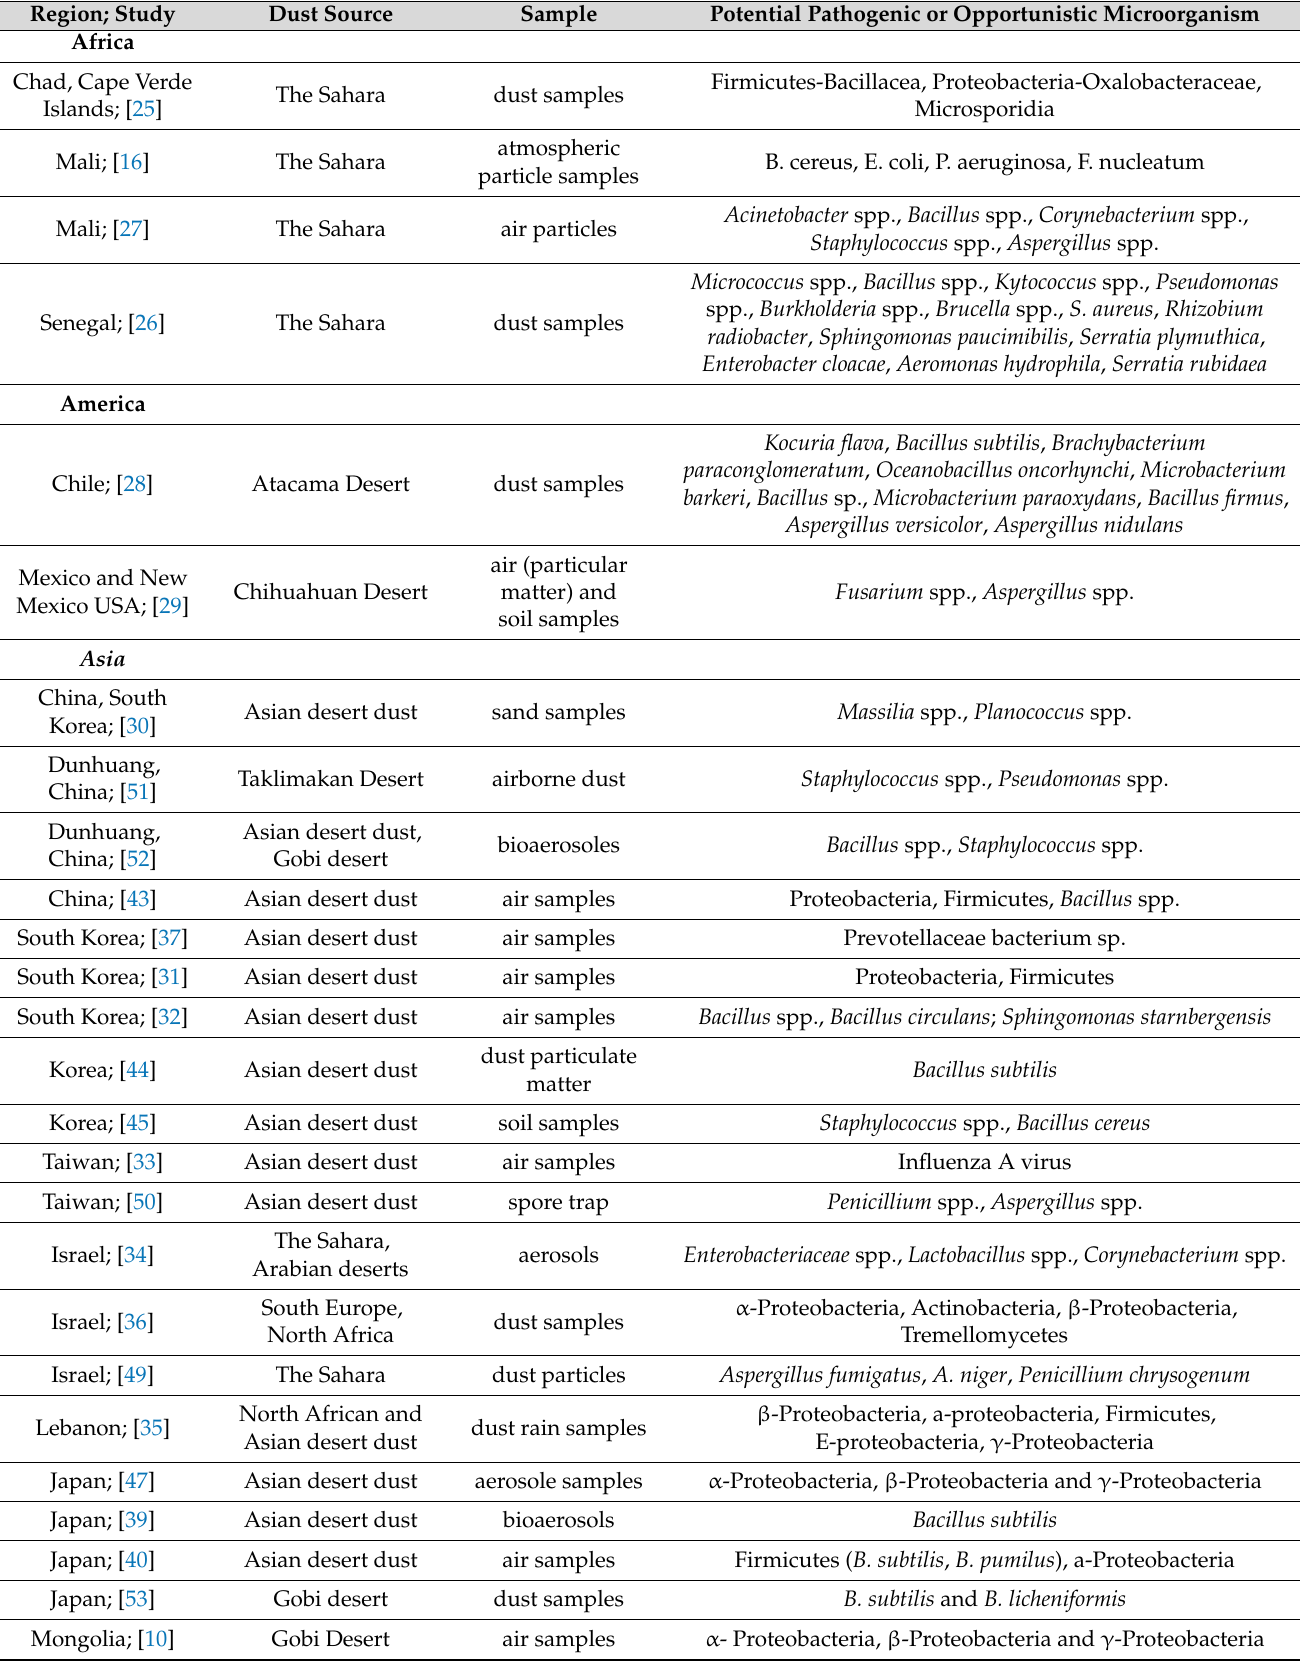
Table 1. Pathogenic and opportunistic microorganisms transmitted via desert dust outbreaks